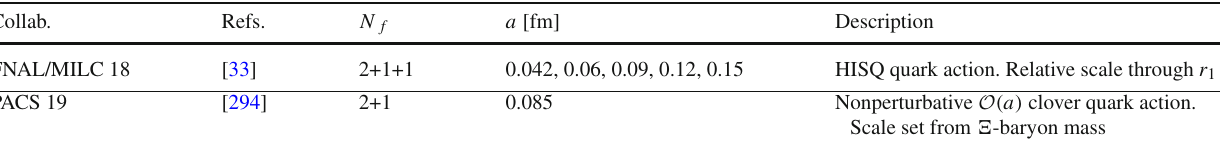
Table 103 Continuum extrapolations/estimation of lattice artifacts in the determinations of f + ( 0 ) Collab.